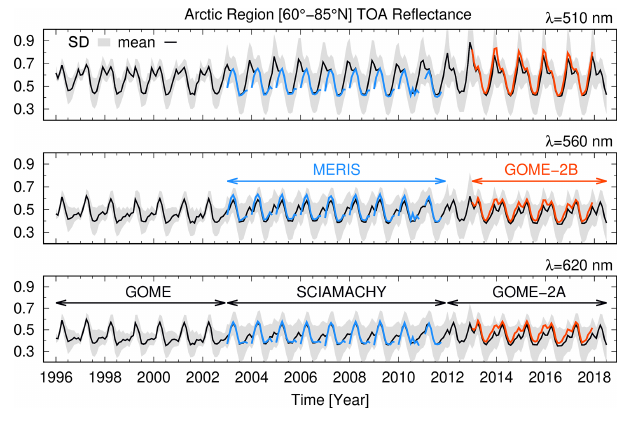
Figure 3. Time series of mean absolute R TOA (red lines) and stan- dard deviation (shaded grey) for the three wavelength bands 510, 560, and 620nm derived from measurements of GOME, SCIA- MACHY, and GOME-2A between 60–85 ◦ N. The companion sen- sors MERIS on board Envisat (blue) and GOME-2B on board MetOp-B (red) have been superimposed for